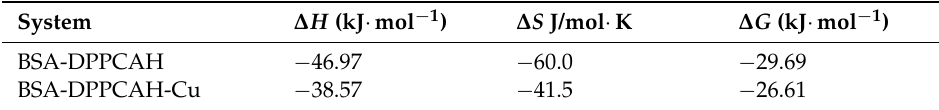
Figure 5. Van’t Hoff plot indicating the interaction between BSA and DPPCAH and DPPCAH-Cu; C BSA = 10 μΜ ; (pH 7.2). Table 1. The calculated values of ∆ H , ∆ S and ∆ G at 288